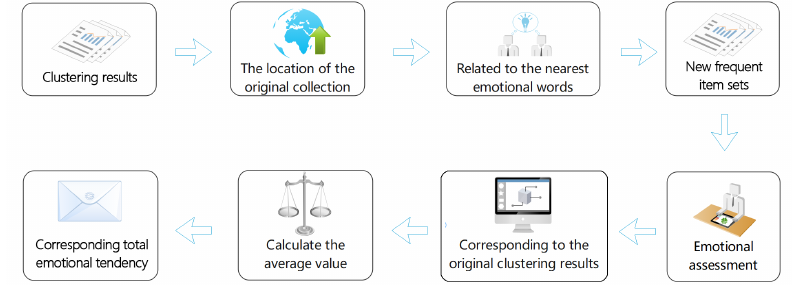
Figure 3. Specific process of matching emotional